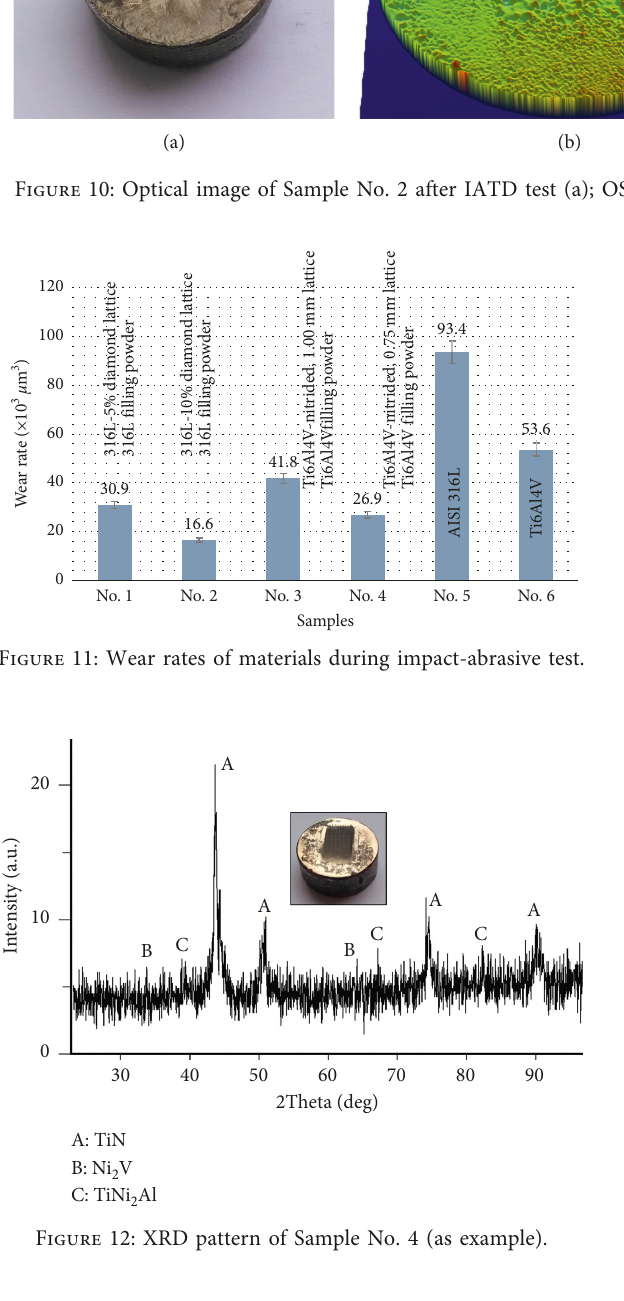
Figure 13: SOLIDWORKSdesignof soliddiamond anddiamondwith